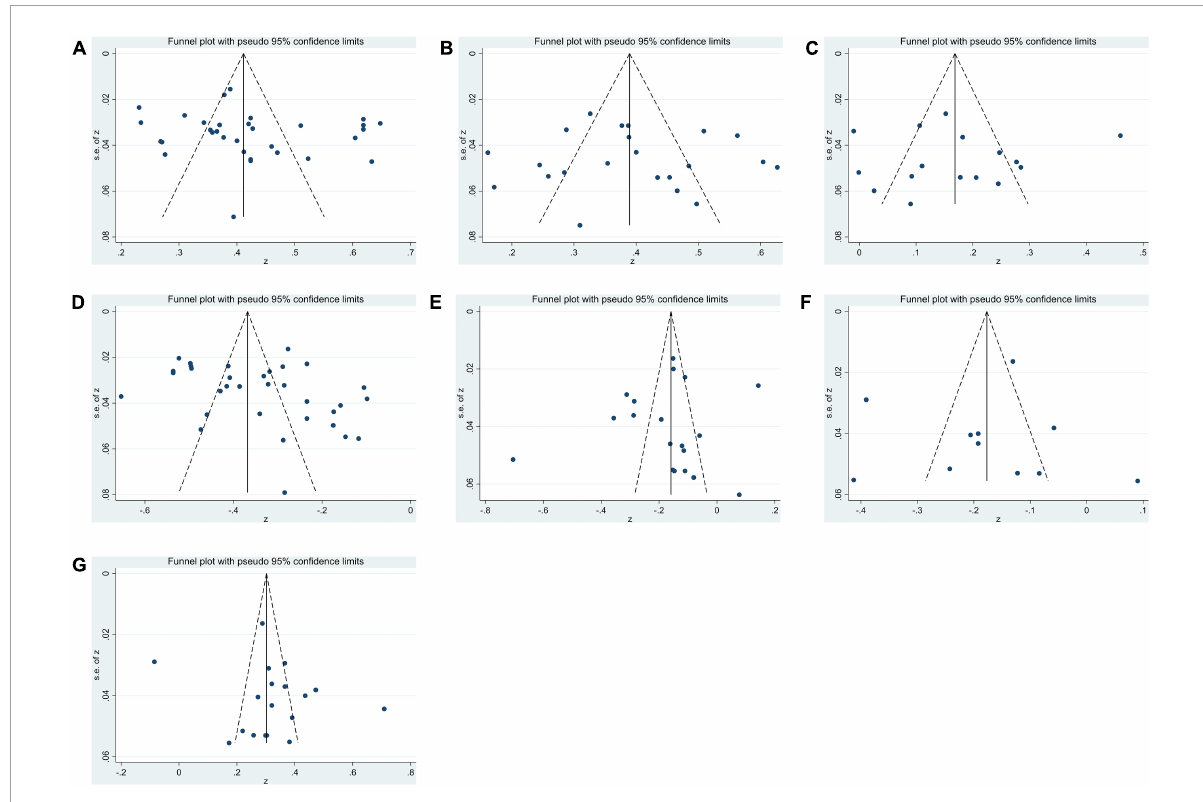
FIGURE2 Funnel plots for assessing publication bias within studies related to (A) alexithymia, (B) attachment anxiety, (C) attachment avoidance, (D) subjective well-being, (E) life satisfaction, (F) positive emotion, (G) negative emotion.